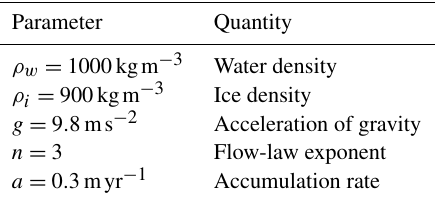
Table 1. The physical parameters of the ice.